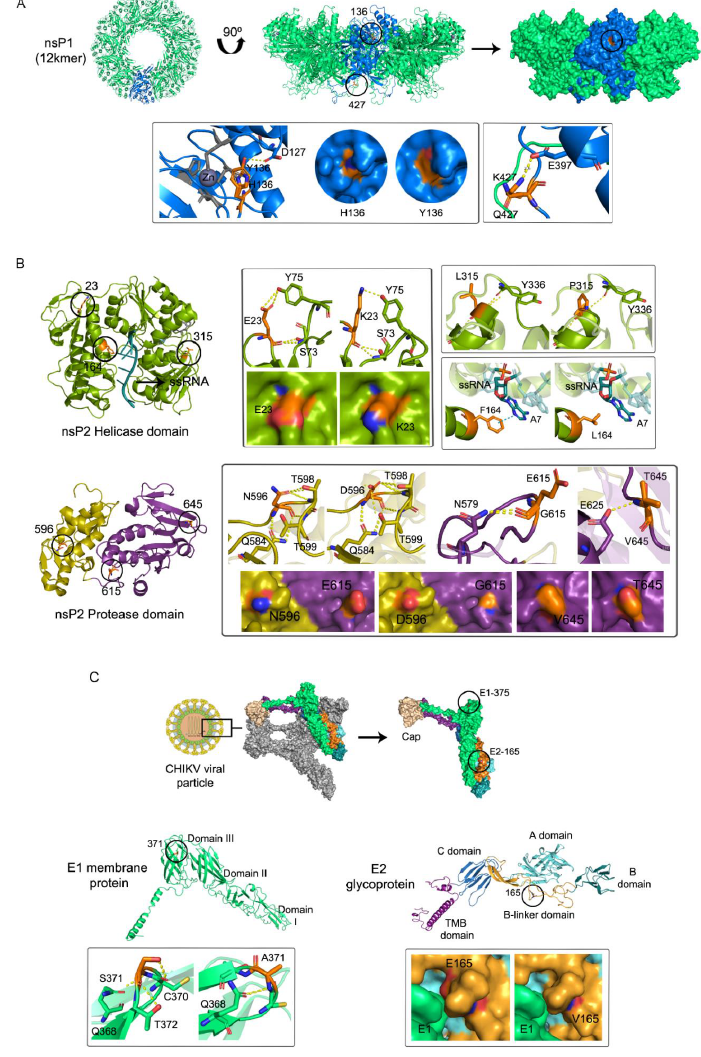
Figure 2. The 3D structures of CHIKV proteins. ( A ) nsP1 protein (residues 2 to 473), modeled based on crystal 7DOP. Top, its ring-shaped structure formed by 12 monomers (green) with a single subunit denoted in blue. On the left, the top view of its cartoon diagram. In the middle, the lateral view of the ring-shaped cartoon diagram, with the surface diagram on the right. The residues 136 and 427 involved in substitutions are denoted with a black circle. Bottom, side-chain interactions of residues H136, Y136, K427, and Q427. The surface disturbances caused by the former are highlighted in circles. Sticks or surface representations of these two residues are denoted in orange. ( B ) nsP2 helicase (green, residues 1–463) and protease (bottom, in yellow and purple, residues 471–791) domains, modeled based on crystals 6JIM and 4ZTB, respectively. On the left, the cartoon diagrams with the residues involved in mutations are denoted in orange and highlighted with black circles. On the right, the interactions involving these residues (orange sticks). Mutations E23K, N596D, E615G, and V645T caused electrostatic-charge shifts, evidenced on the protein surface with the red color (negative potential) representing an excess of negative charges near the surface due to oxygen’s presence, while the blue (positive potential) represents a positively charged surface, usually in line with nitrogen’s presence. ( C ) Virion surface with capsid, E1, and E2 modeled based on crystal 6NK5. Zoomed in surface and cartoon representations of E1 (green, residues 1–439) and E2 glycoproteins (residues 5–423) with its domains A (light cyan), B (dark cyan), and C (blue), connected by the beta-linker (yellow), and the transmembrane domain that connects the E2 protein with the viral membrane (purple). Bottom, cartoon representation of polar interactions involving residue S371 or A371 on E1, and surface disturbances caused by substitution E165G on